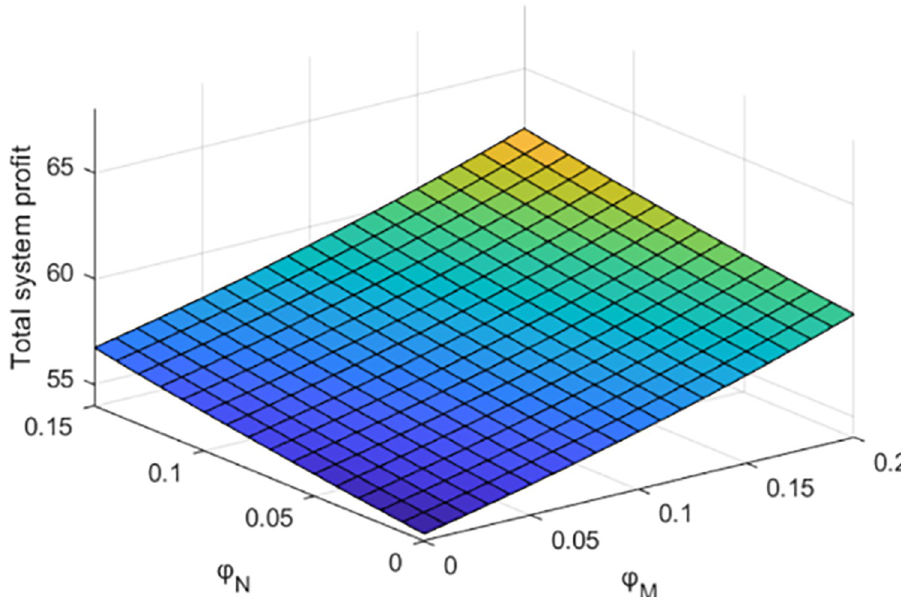
Fig 10. Effect of parameter φ N and φ N on total profit of debt